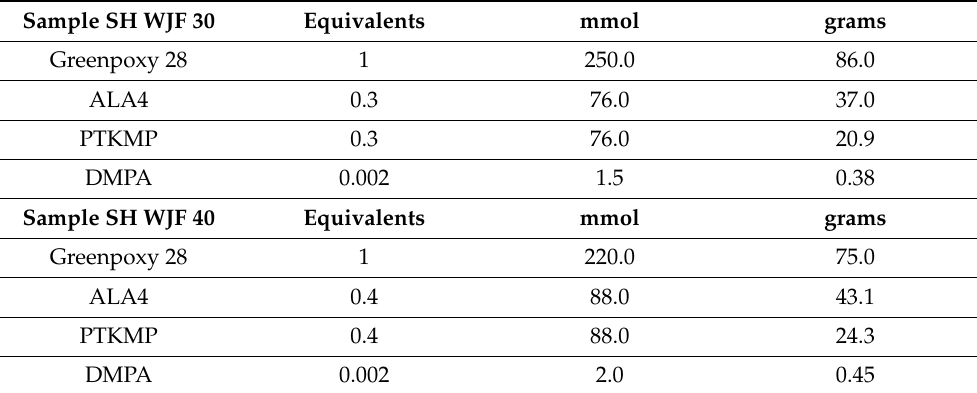
Table 1. Components of the epoxy/thiol-ene photocurable formulations.